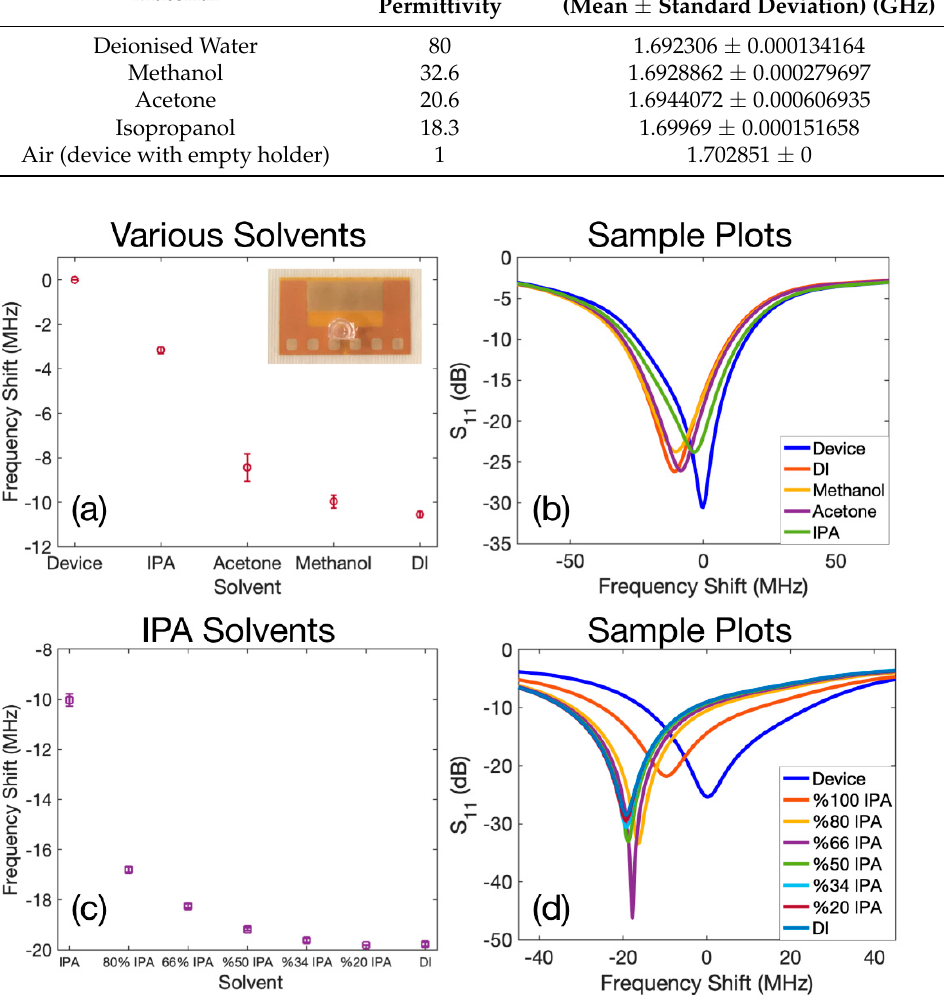
Figure 5. ( a ) Resonant frequencies obtained when various solvents were filled inside the PDMS droplet holder, the Device represents the case where the PDMS holder was empty. ( b ) Sample S 11 spectra measured for various solvents. ( c ) Average shift in resonant frequencies of prepared IPA/DI solvents compared to the case where the PDMS holder was empty. ( d ) Sample S 11 spectra for prepared IPA/DI solvents.